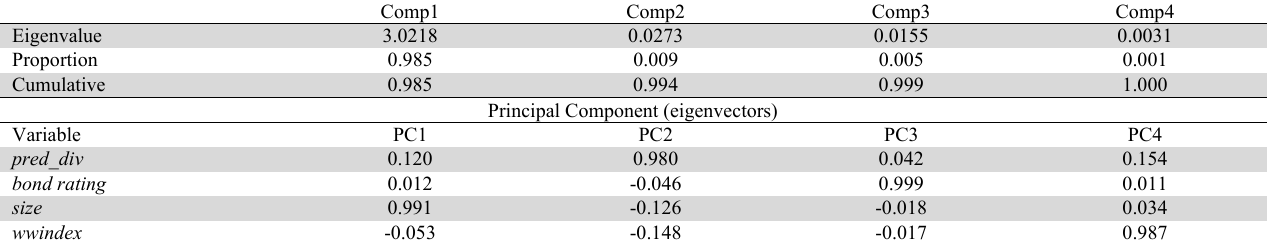
Results of Principal Component